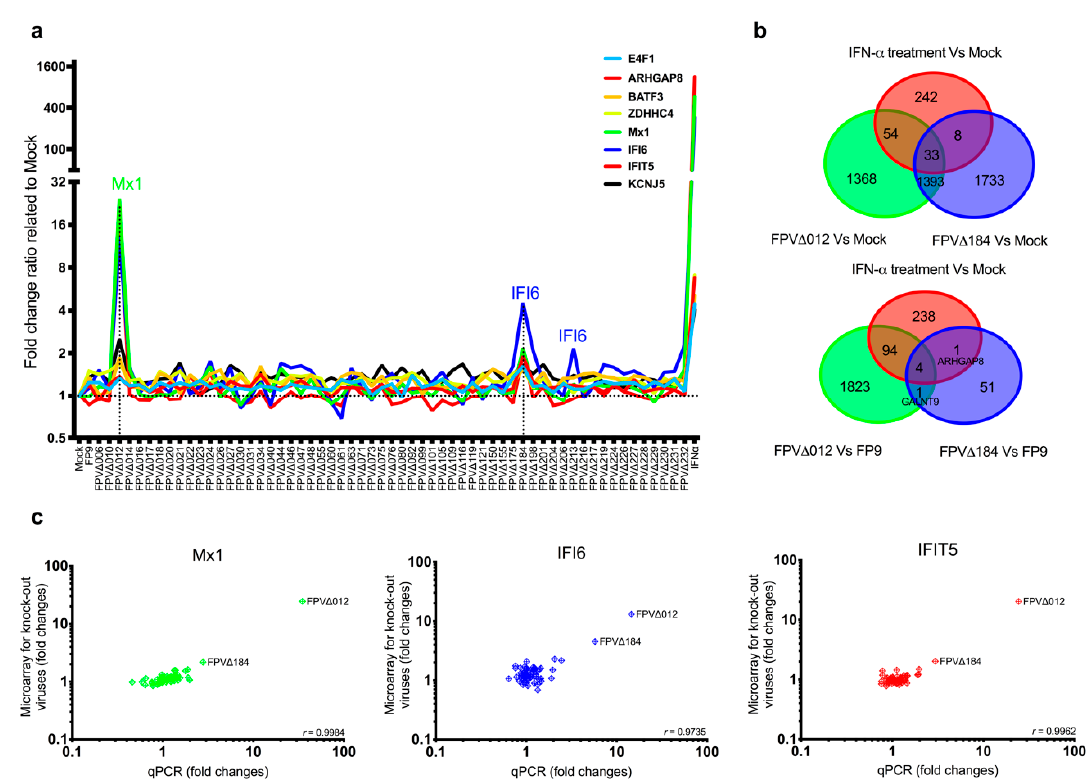
Figure 1. Disruption of FPV012 (a known FP9 immunomodulator gene) and FPV184 -induced overlapping subsets of IFN-stimulated genes (ISGs). ( a ) Gene expression of selected ISGs (E4F1, ARHGAP8, BATF3, ZDHHC4, Mx1, IFI6, IFIT5, KCNJ5Z) for all knockout viruses measured by microarrays (fold-change relative to mock-infected chicken embryo fibroblasts (CEFs)). ( b ) Venn diagrams showing numbers of genes differentially regulated by FWPV ∆ 012, FWPV ∆ 184 or IFN- α in comparison with mock-infected (upper) or parental FP9-infected (lower) cells. The full gene datasets are listed in Table S2. ( c ) Comparison of median differential expression levels for 3 selected transcripts determined by microarray and qPCR analysis (Mx1, IFI6, IFIT5). Plots show log10 expression fold change for the selected genes for CEFs infected with all knockout FP9 mutant viruses compared to mock-infected CEFs. Pearson correlation coefficients ( r ) are shown in the lower right corner of each plot.